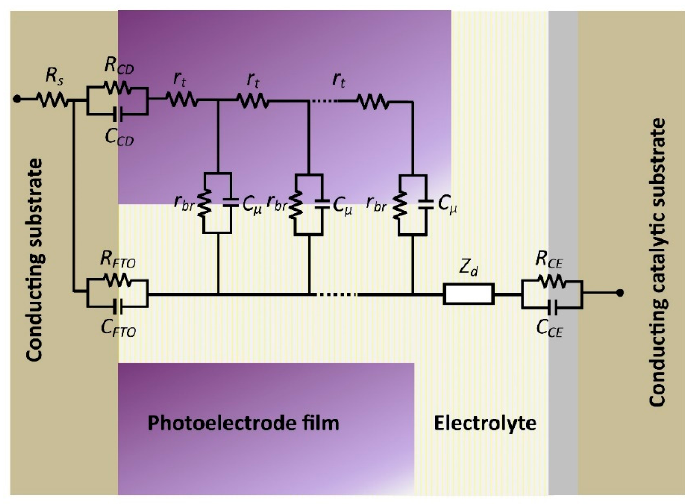
Figure 7. Equivalent circuit of a dye-sensitized solar cell.